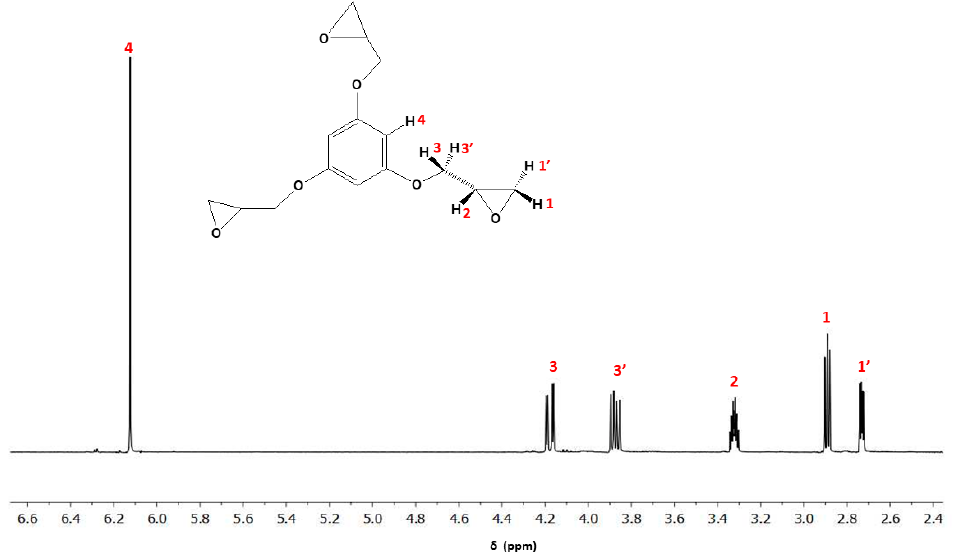
Figure 2. 1 H-NMR spectrum of 3EPO-Ph monomer in CDCl 3 .